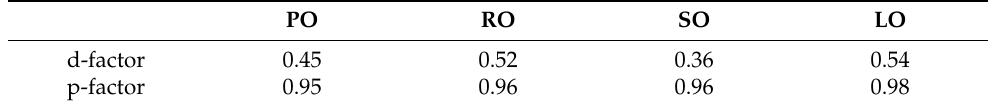
Table 6. Uncertainty measuring parameters for different ANN